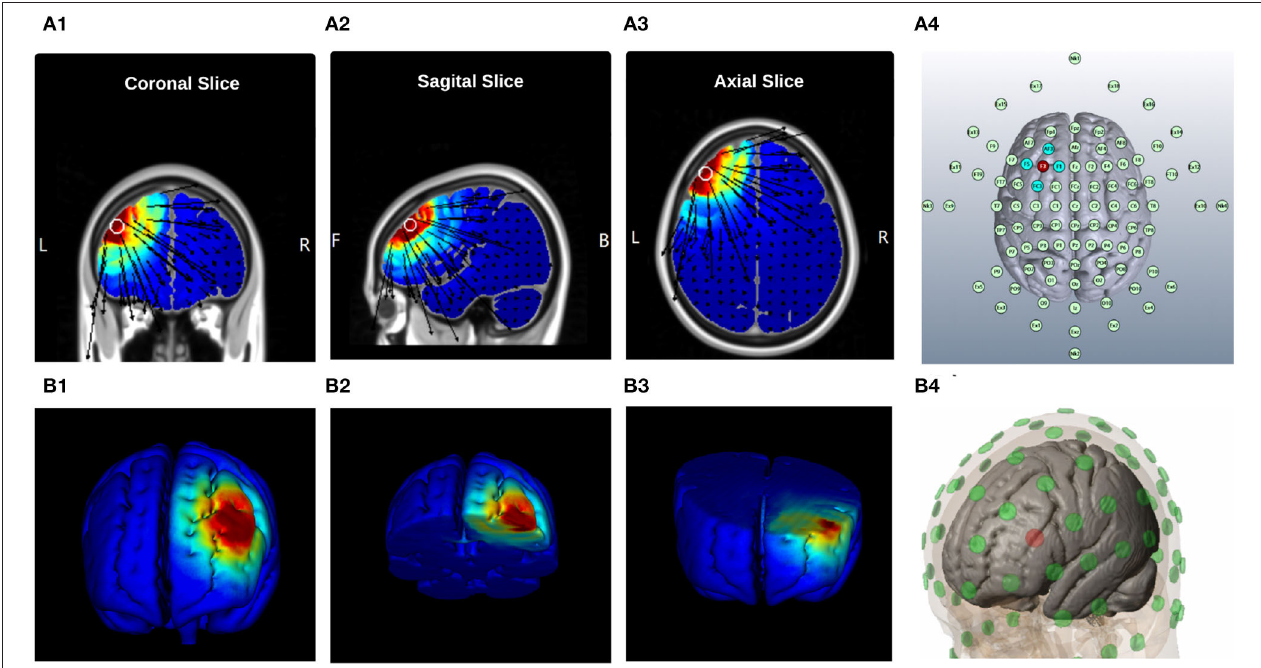
FIGURE 1 | Current Distribution Model, (A) 2D Brain Cross-sections, and MNI position = [ − 42, 36, 35 ] (A1) Coronal Slice [56], (A2) Sagital Slice [49], (A3) Axial Slice [75], and (A4) Electrodes layout, “EEG 10-10 system”| Anode: F 3 , Cathodes: F 1 , AF 3 , AC 3 , and F 5 ; (B) 3D Brain Cross-sections, (B1) Full Brain, (B2) Top Brain sections, plane-cut: angle by Y[ − 34.4], angle by X[3.6], and distance from center[7.7]; (B3) Bottom Brain section, plane-cut: angle by Y[97.1], angle by X[5.2], and distance from center[ − 22.6]; and (B4) Electrodes layout, “MNI Atlas 93-electrodes head model,” Anode: F 3 , Cathodes: F 1 , AF 3 , AC 3 , and F 5